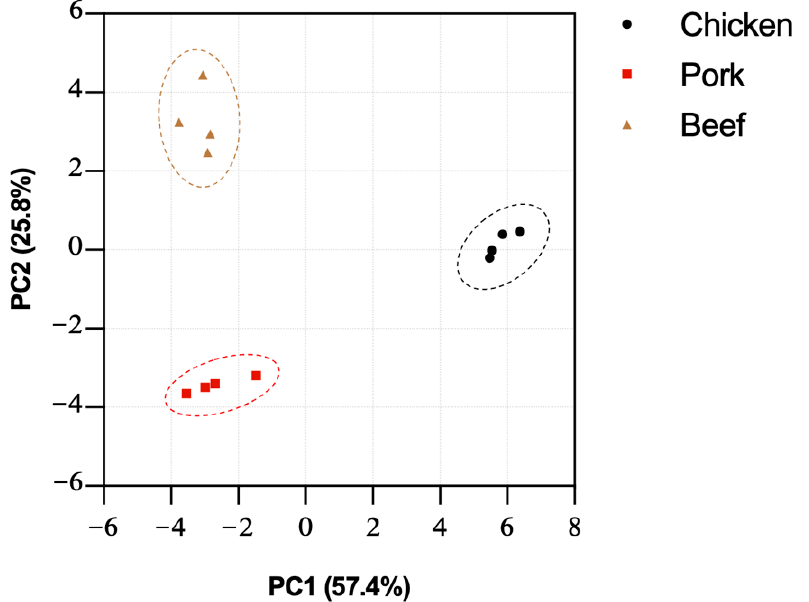
Figure 6. Principal component analysis was performed on relative abundances of O- and N-glycans of chicken, pork, and beef. A clear separation was observed between meat from different species. Each dot represents an independent biological replicate.